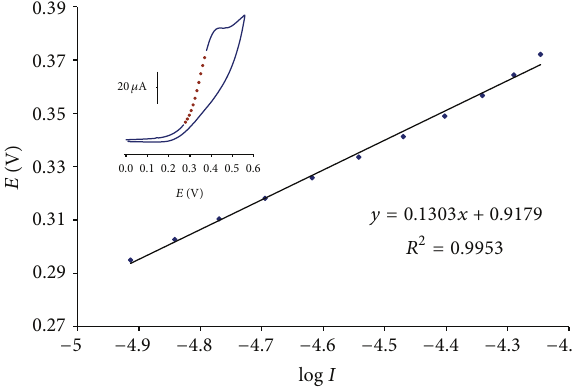
Figure 4: Tafel plot for FCAD/NiO/NPs/CPE in 0.1molL −1 PBS (pH 7.0) with scan rates of 20 mVs −1 in the presence of 1.0mM